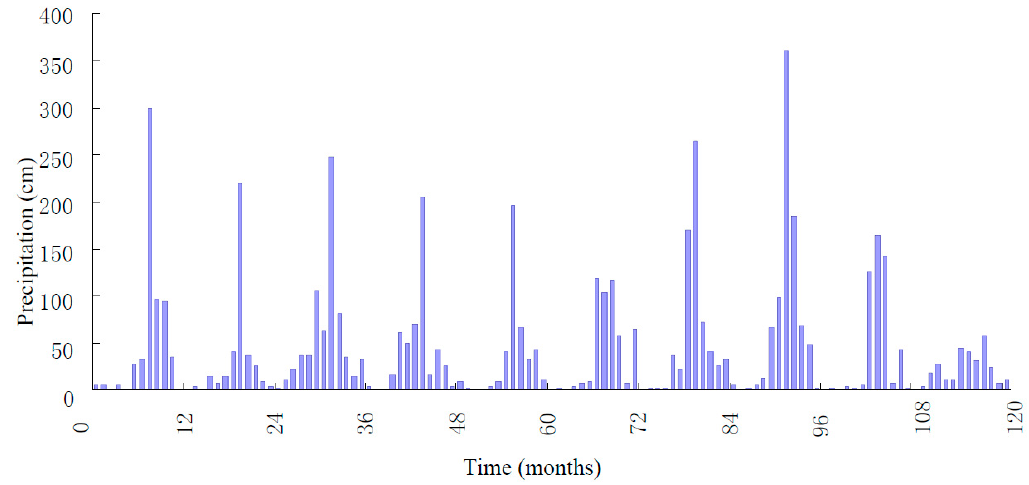
Figure 6. Monthly precipitation in a ten-year series from 1988 to 1997.